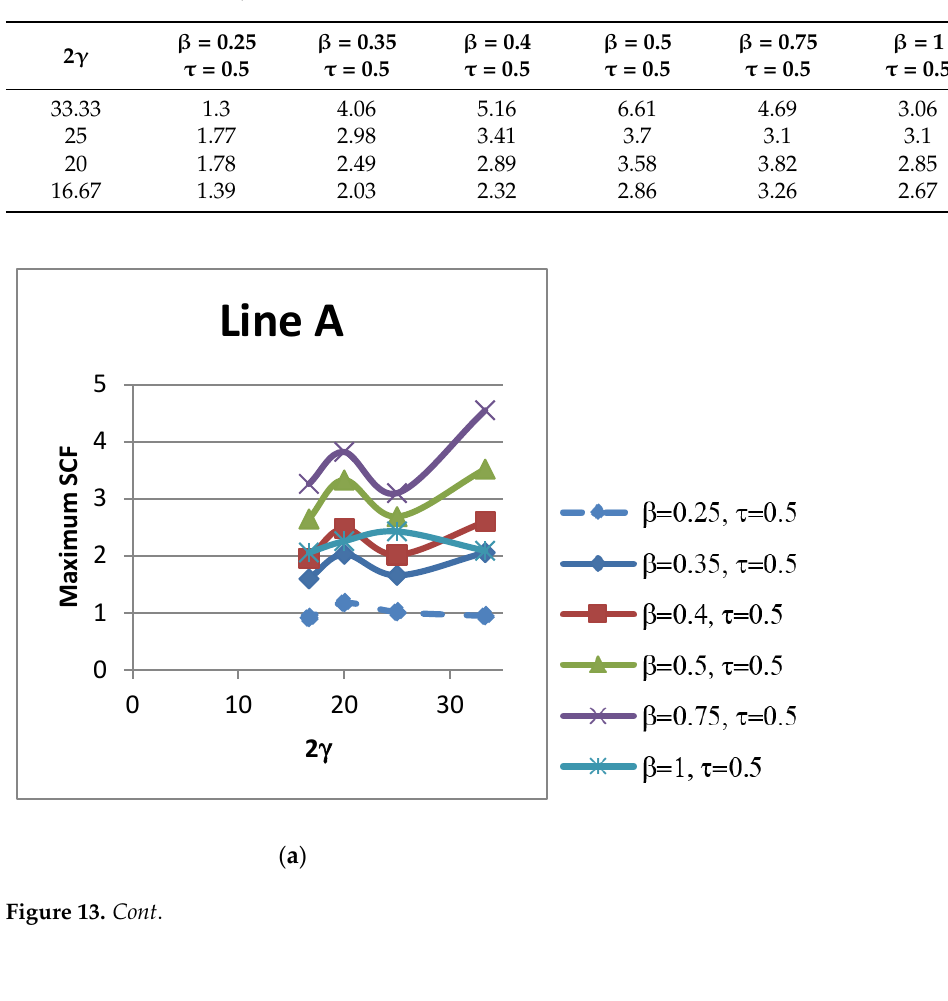
Figure 12. Influence of 2 γ on maximum SCFs. Table 13. Influence of 2 γ on maximum SCFs.